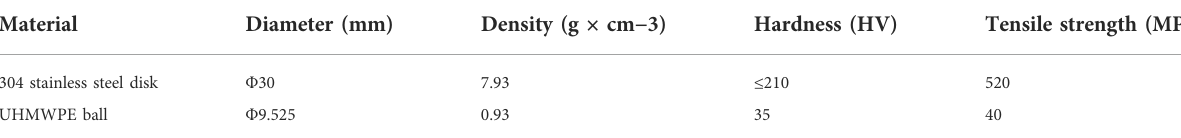
TABLE 1 Properties of the tribological test